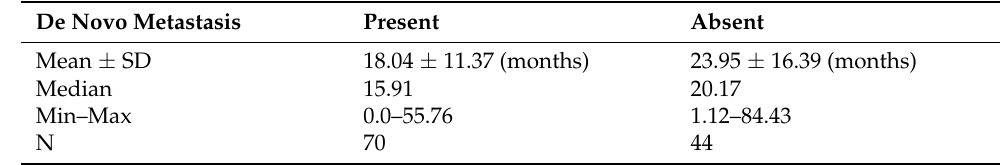
Table 3. Progression group and de novo metastasis.